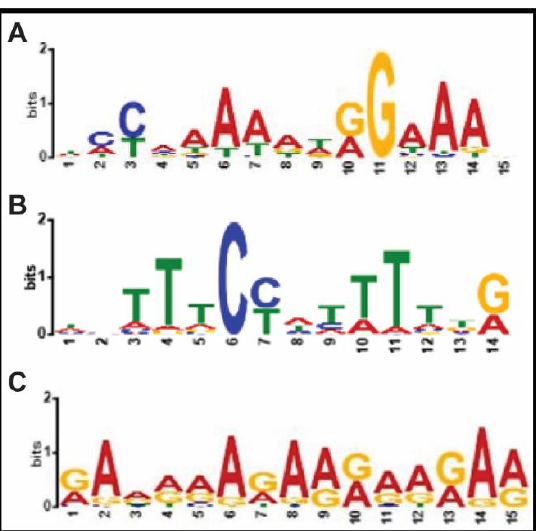
Figure 2. ChIP-MEME analysis for binding regions: ( A ) common in ChIP-Seq and ChIP-Chip; ( B ) unique in ChIP-Seq; and ( C ), unique in ChIP-Chip. The sequences of the genome fragments were retrieved using CisGenome [8] and ChIP-MEME performed using the default settings [10].